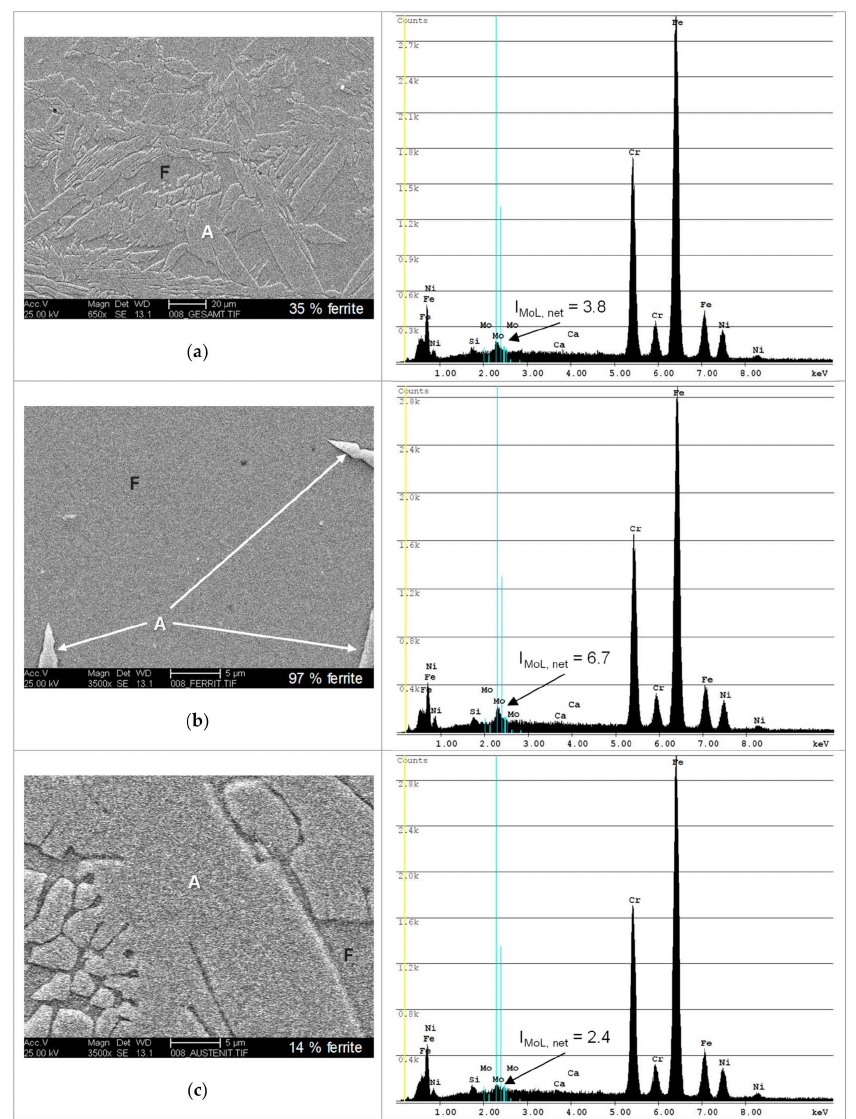
Figure 6. Net intensity of the molybdenum peak as a function of the ferrite–austenite distribution in the DSS weld metal microstructure, ( a ) balanced ferrite–austenite ratio, ( b ) predominantly ferrite, ( c ) predominantly